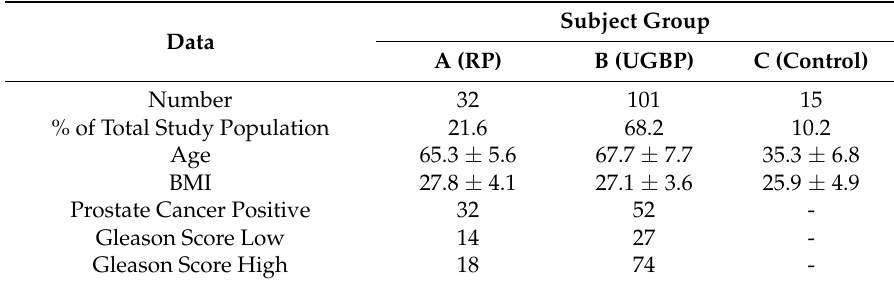
Table 1. Patient groups, clinical and histopathologic characteristics. Values are presented as means/SDs, medians/ranges or